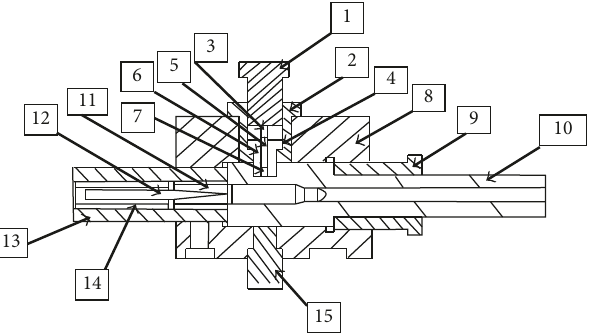
Figure 11: Mechanism for piezo and copper crusher at chamber (25 mm from chamber end)